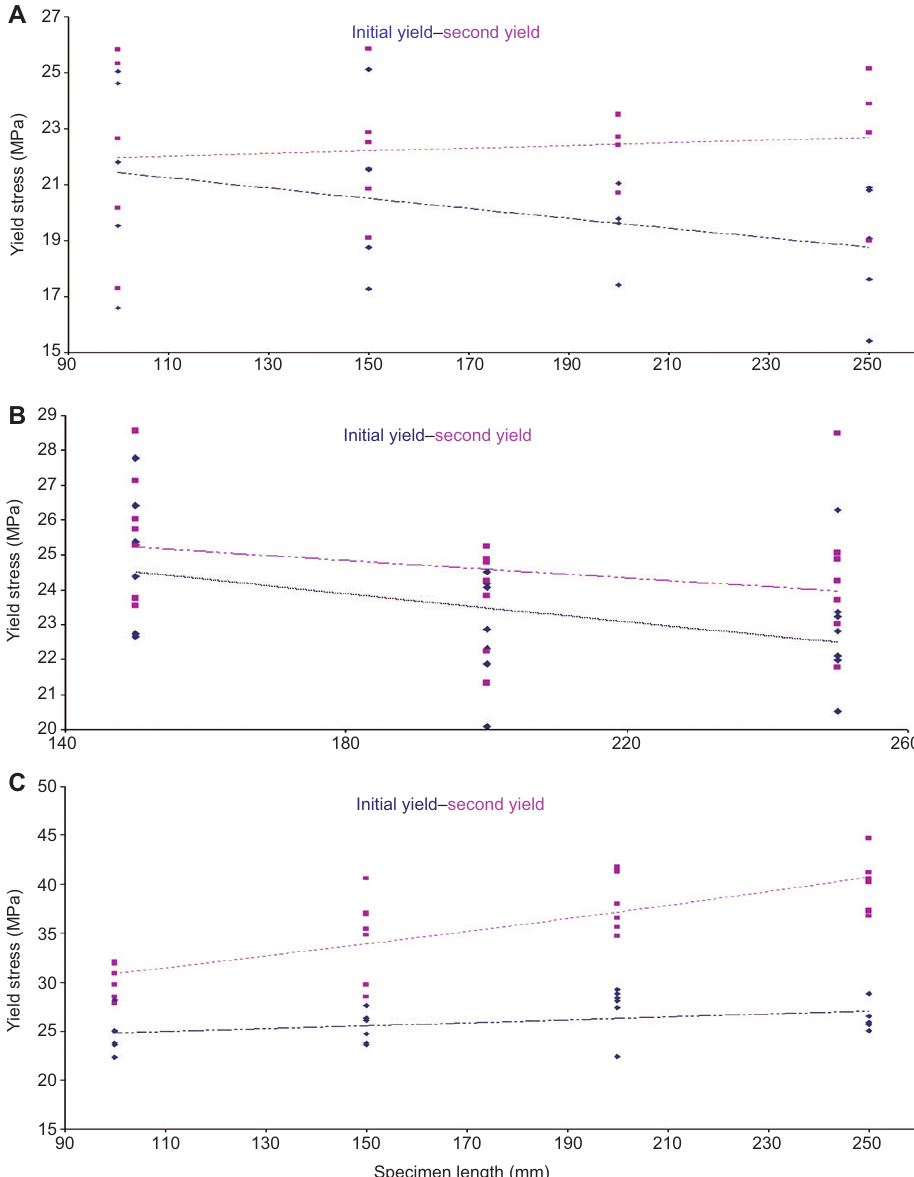
Figure 9 Effect of specimen length on initial and second yield stresses for (A) 1 mm, (B) 2 mm and (C) 3 mm diameter NiTi shape memory alloy